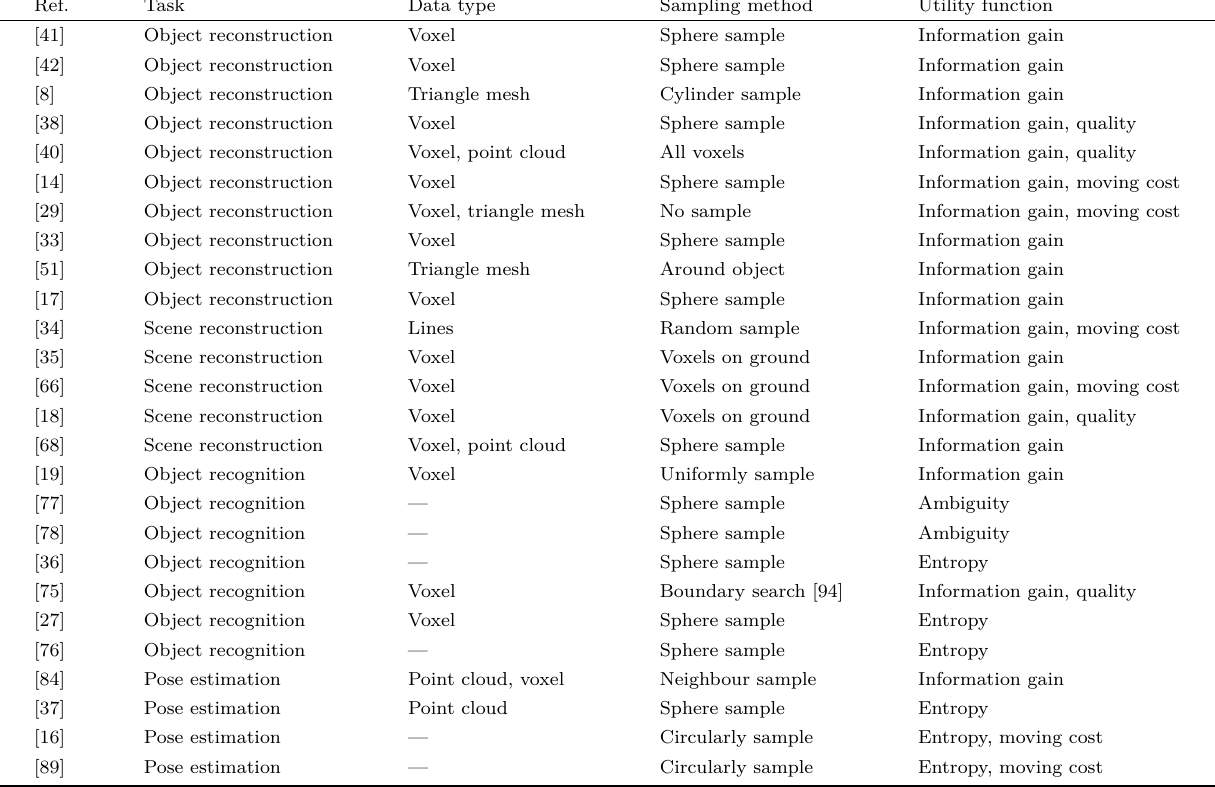
Table 4 Work using search-based approaches